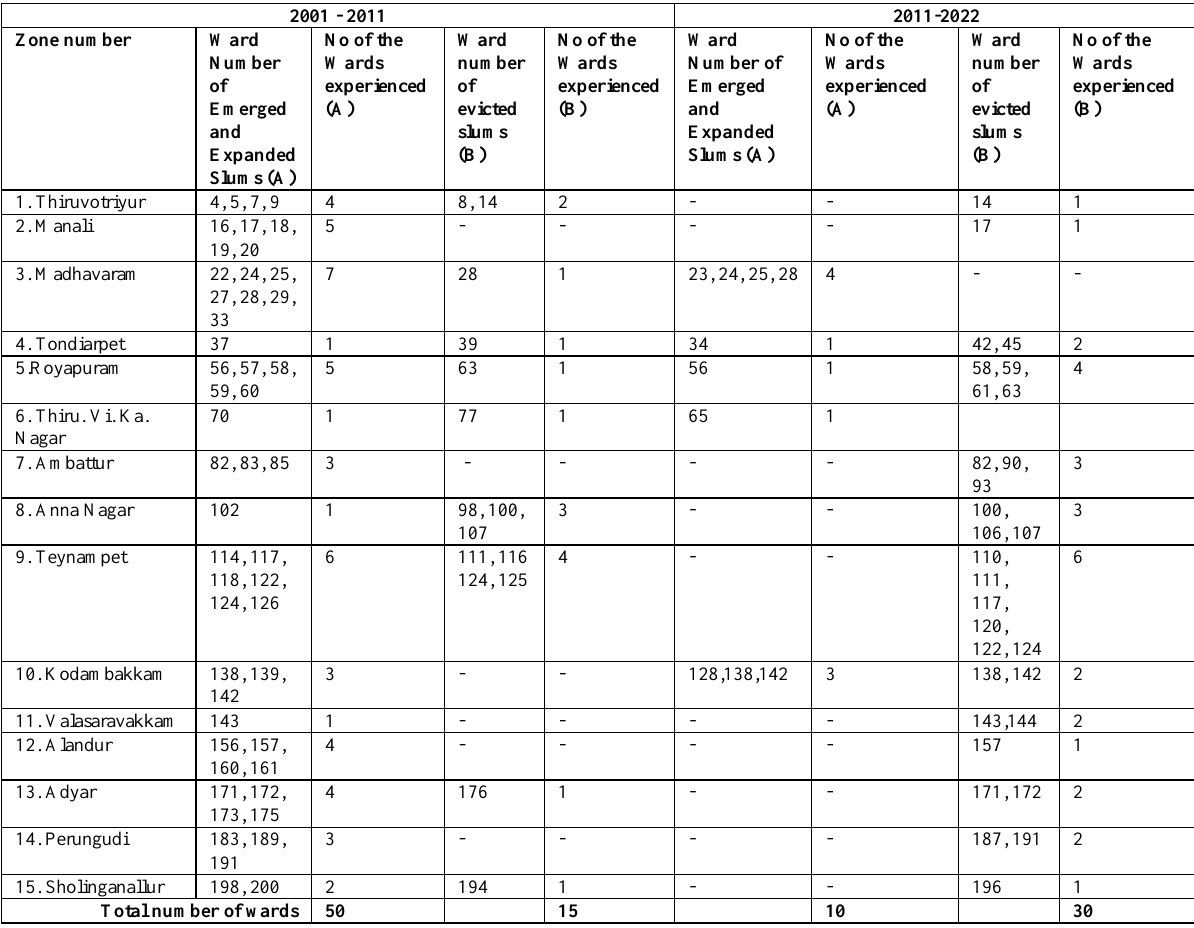
Table 2. Zone wise distribution of emerged and existing slums